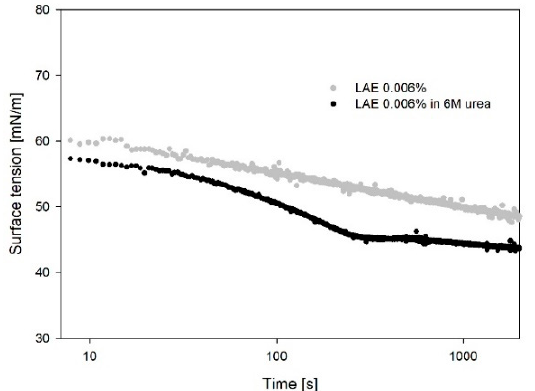
Figure 5. The effect of the addition of urea (6 mol/L) on the surface tension of 0.006 wt.% LAE— Mirenat solution (85% purity).